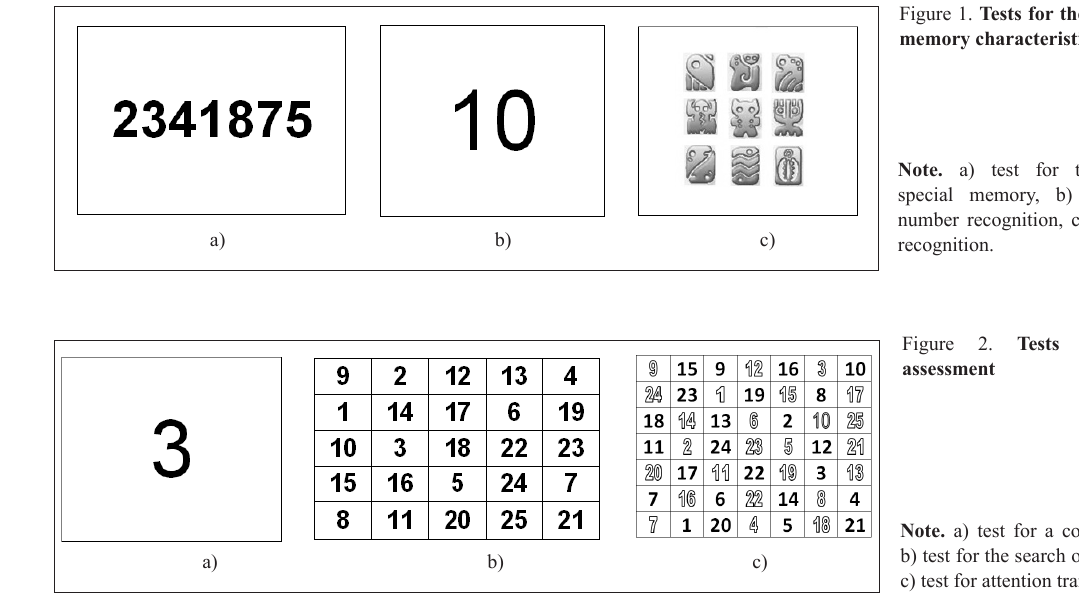
Figure 2. Tests for attention assessment